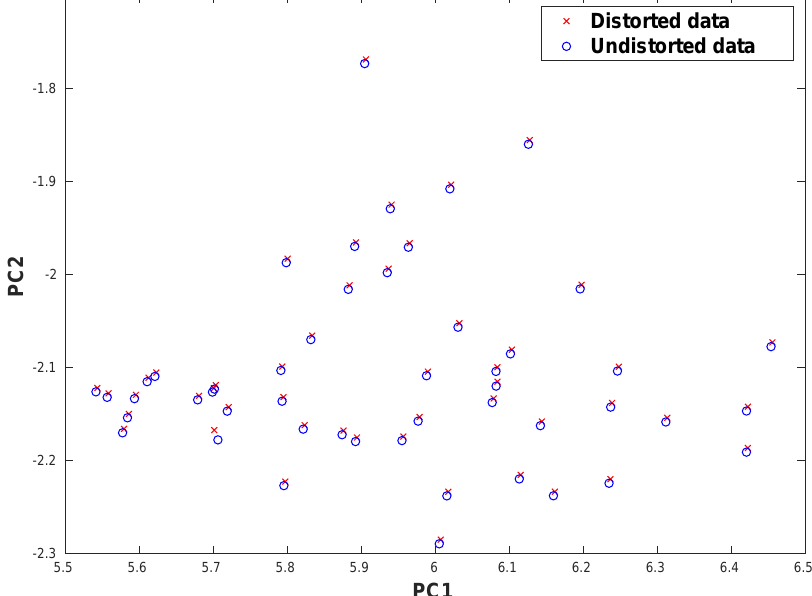
Figure 4. Plot of the first two principal components (PC) of the original mole spectral signatures (blue) and the spectral signatures of the distorted data (red) (see Figure 1b). Note the complete overlap of the two data sets, save for a small change at around (PC1, PC2) = (5.7, − 2.2).